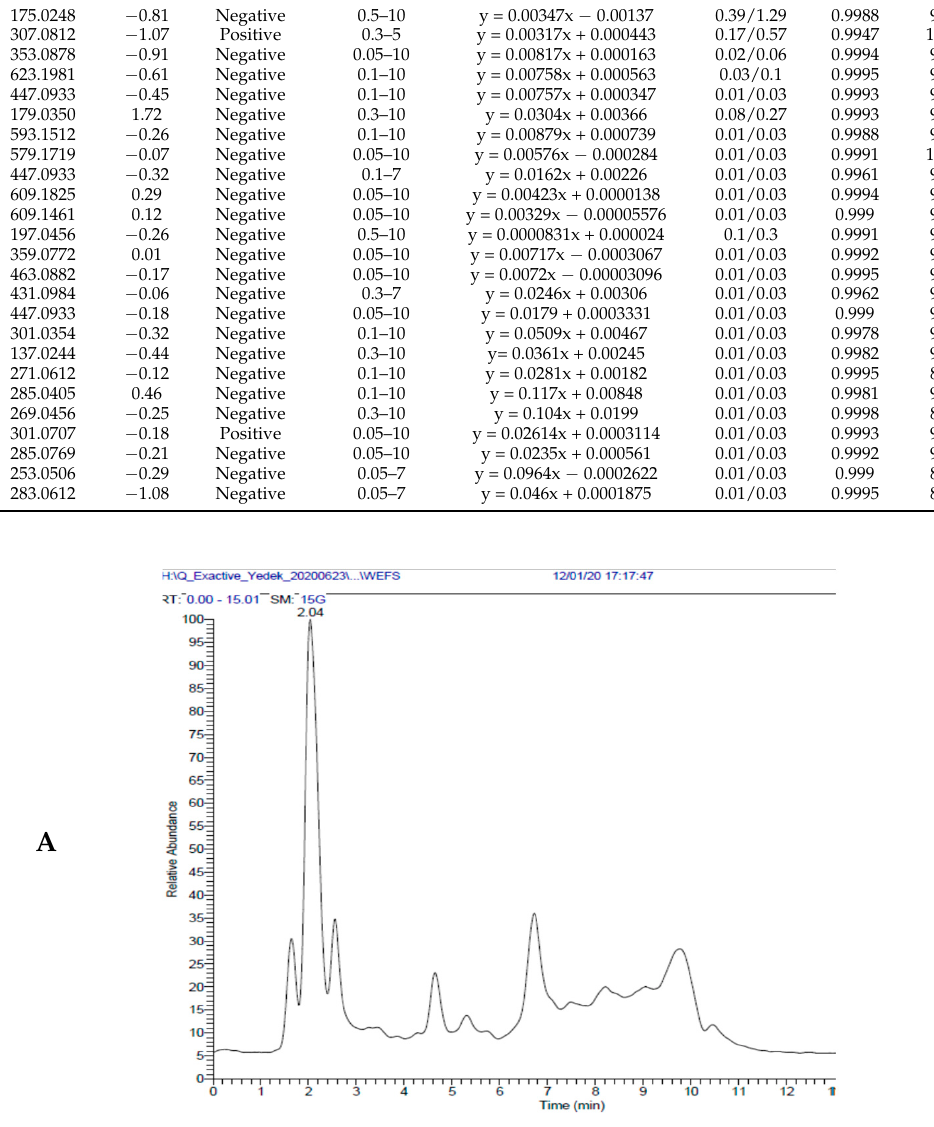
Table 4. LC-HRMS method parameters of selected compounds in EEFS and WEFS (EEFS: evaporated ethanolic extract of aerial parts kınkor ( Ferulago stellata ); WEFS: lyophilized water extract of aerial parts of kınkor ( Ferulago stellata )). Compounds Ascorbic acid